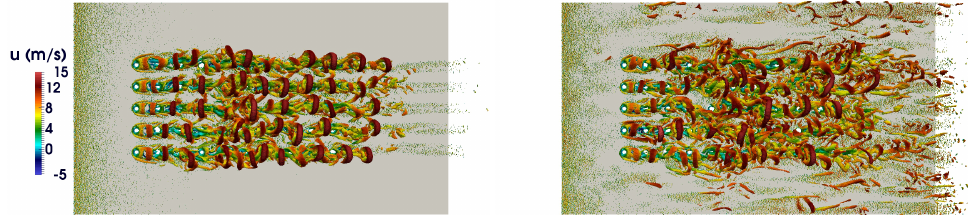
Figure 12. Instantaneous Q-criterion isosurfaces (10 6 s − 2 ) along the plate, with ( right ) and without ( left ) turbulence injection at inlet. t = 0.